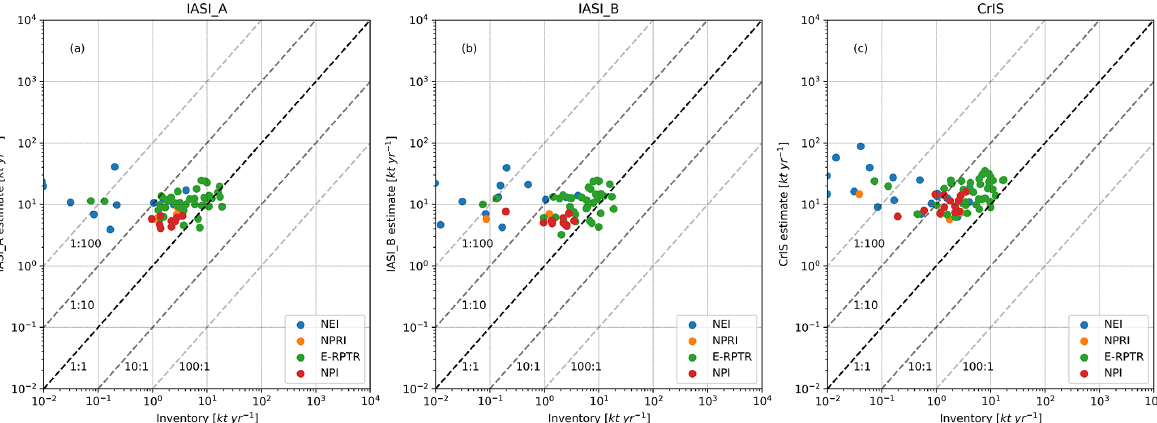
Figure 8. IASI-A, IASI-B and CrIS emission estimates vs. the regional point-source emission inventories. Point-source values are the sum of all emissions in a square 0.50 ◦ × 0.25 ◦ (long, lat) surrounding each source